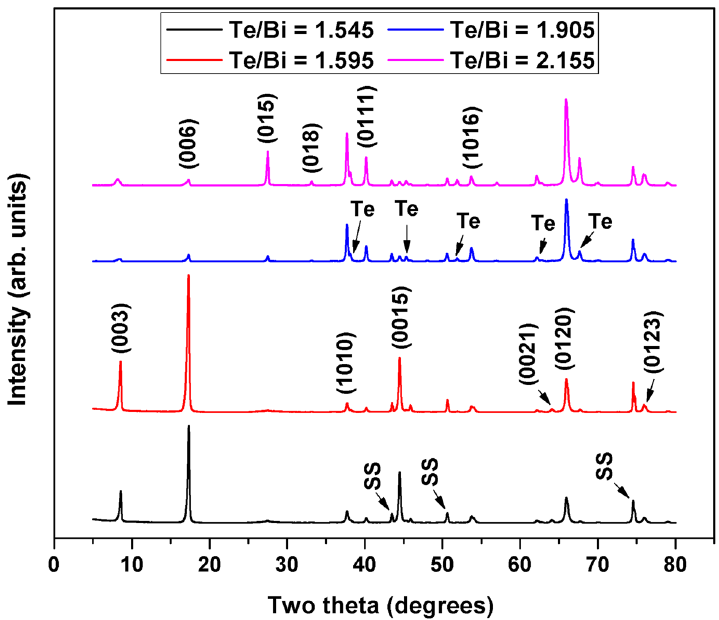
Figure 7. RT XRD patterns for the Bi–Te thin films after thermal